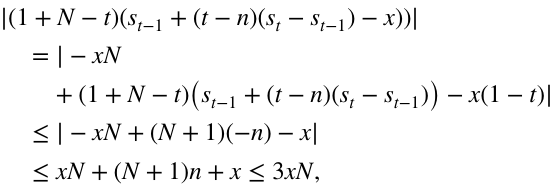
Fig. 2 Schematic graphics of 𝜃 i ( t ) ; it ramps from zero to ̂ n i within t ( i ) , t ( i + 1 )] some time interval [ , with step size equal to 1, and outside the interval, remains constant. This interval corresponds to the one of E span of process i ( ⋅